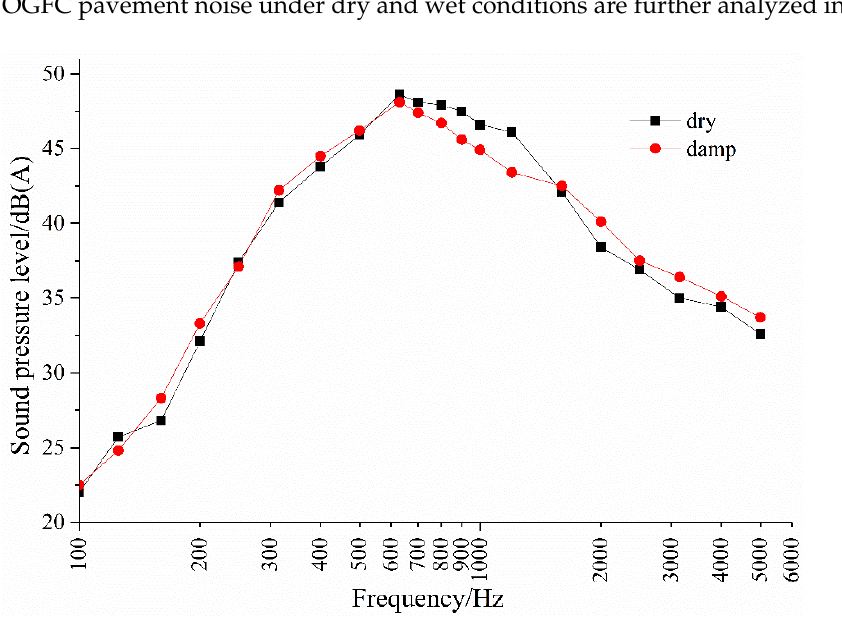
Table 9. Measurement and analysis results of different pavement noises.